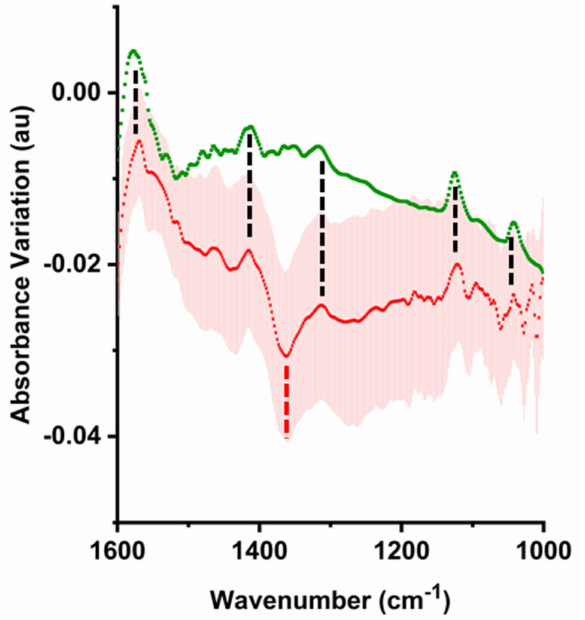
Figure 3. Detection of Lactate Formation. Comparison of the differential absorbance in the fingerprint region after 25 min averaged over 3 cells (the red line shows the mean of the spectra, while the shaded area shows values of ± σ at each wavenumber), with the absolute absorbance of 10 mM sodium lactate (green line). The dashed black lines highlight increasing lactate absorption. The dashed red line highlights decreasing bicarbonate